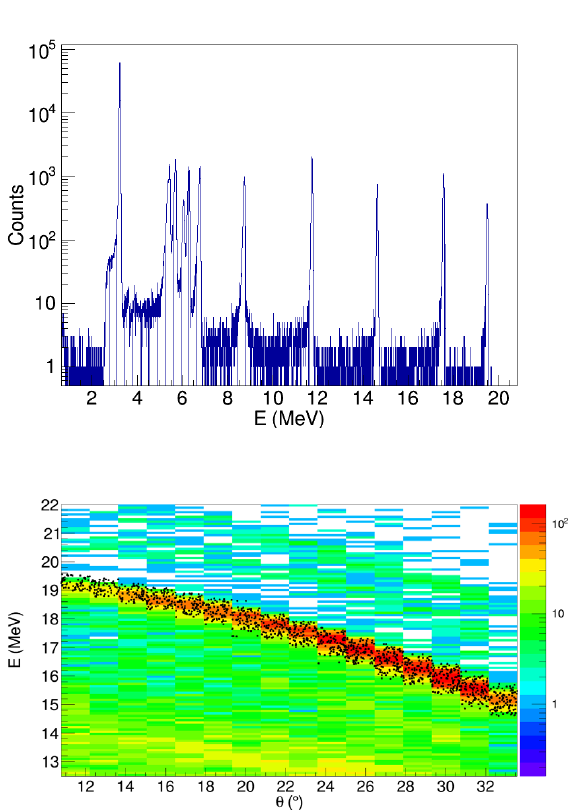
Figure 5. The 19 F(p, α 0 ) 16 O reaction at 18.5 MeV with red and simulations with